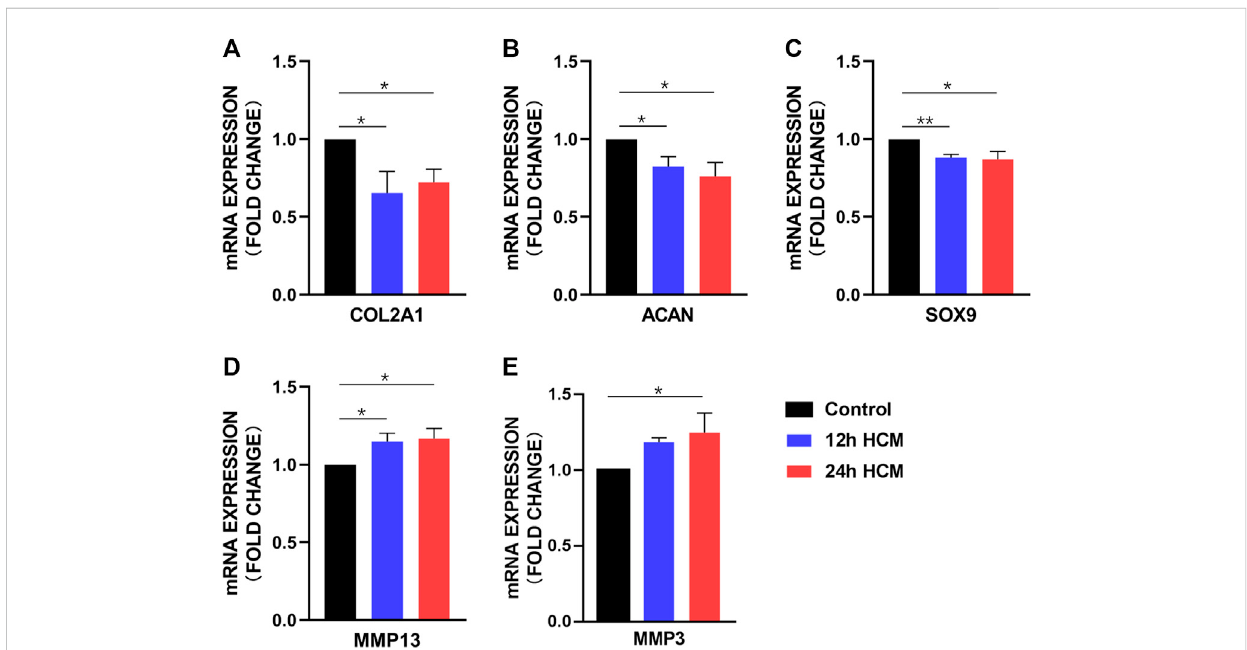
FIGURE 3 RT-PCR analysis of the osteoarthritis biomarker mRNA levels in human primary chondrocytes stimulated with a conditioned medium from hypoxia (HCM) for 12 h. (A) COL2A1, (B) ACAN, and (C) SOX9 expression was signi fi cantly decreased in human primary chondrocytes stimulated with 12 and 24 h HCM compared to the 12 and 24 h conditioned medium from normoxia (NCM). (D) MMP13 expression was signi fi cantly increased in human primary chondrocytes stimulated with 12 and 24 h HCM compared to 12 and 24 h NCM, respectively. (E) MMP3 expression was signi fi cantly increased in human primary chondrocytes stimulated with 12 h HCM compared to those stimulated with 12 h NCM but not 24 h HCM compared to 24 h NCM.